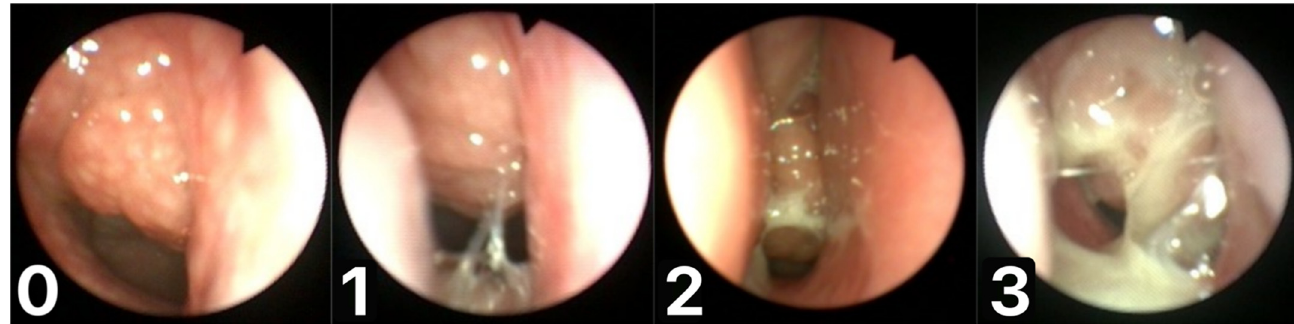
Figure 1. Mucus of Adenoid Scale by Nasopharyngoscopy Assessment (MASNA): ( 0 )—no mucus; ( 1 )—residue of clear watery mucus; ( 2 )—some amount of dense mucus; ( 3 )—copious thick dense